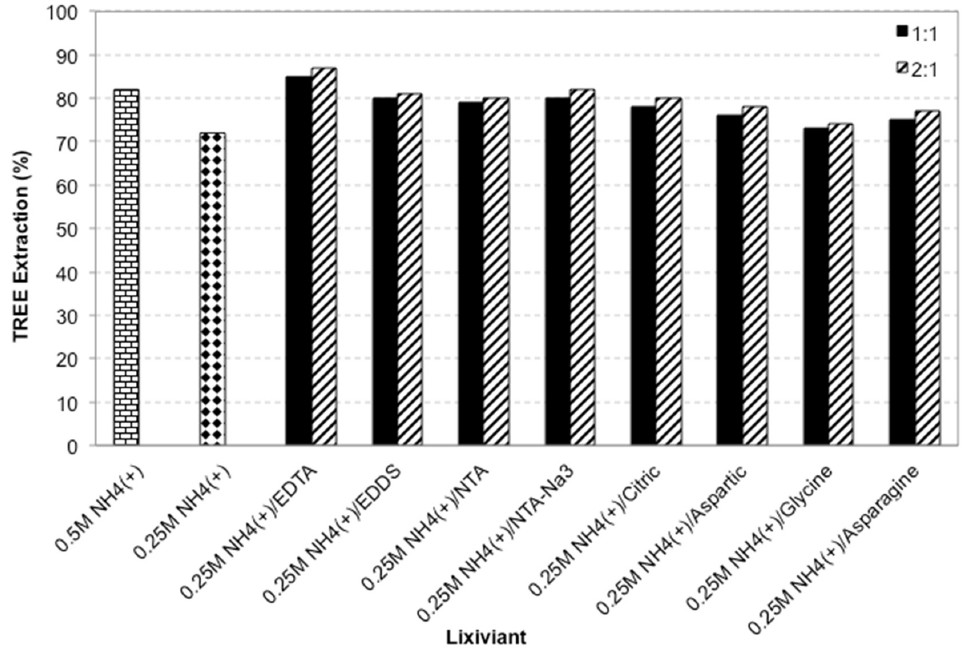
Figure 1. Influence of chelating agent addition on the TREE extraction with ammonium sulfate (ambient conditions, 30 min, L/S = 2/1). Figure 1 indicates that the 2:1 stoichiometric excess did not lead to appreciable im-